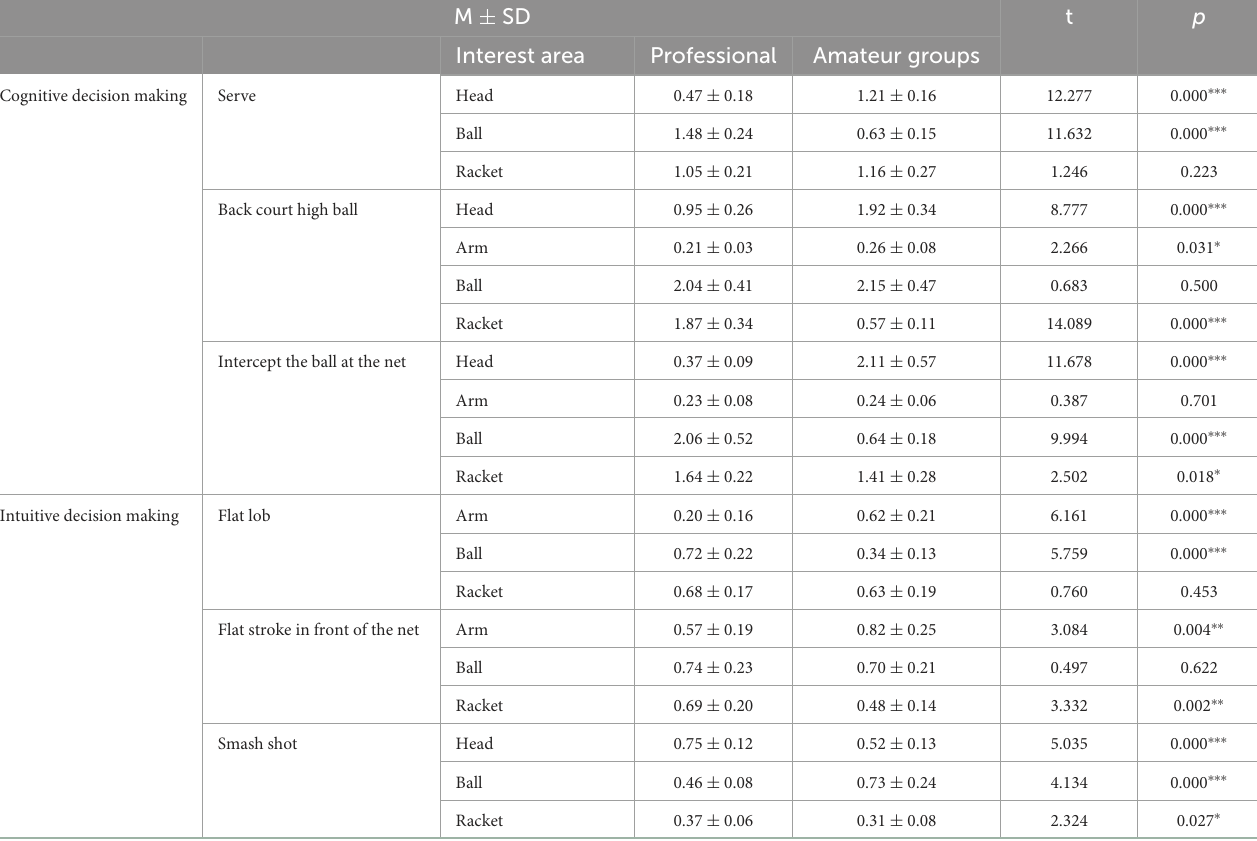
TABLE 4 A comparison of the number of fixation points in the different areas of interest between the two groups (unit: